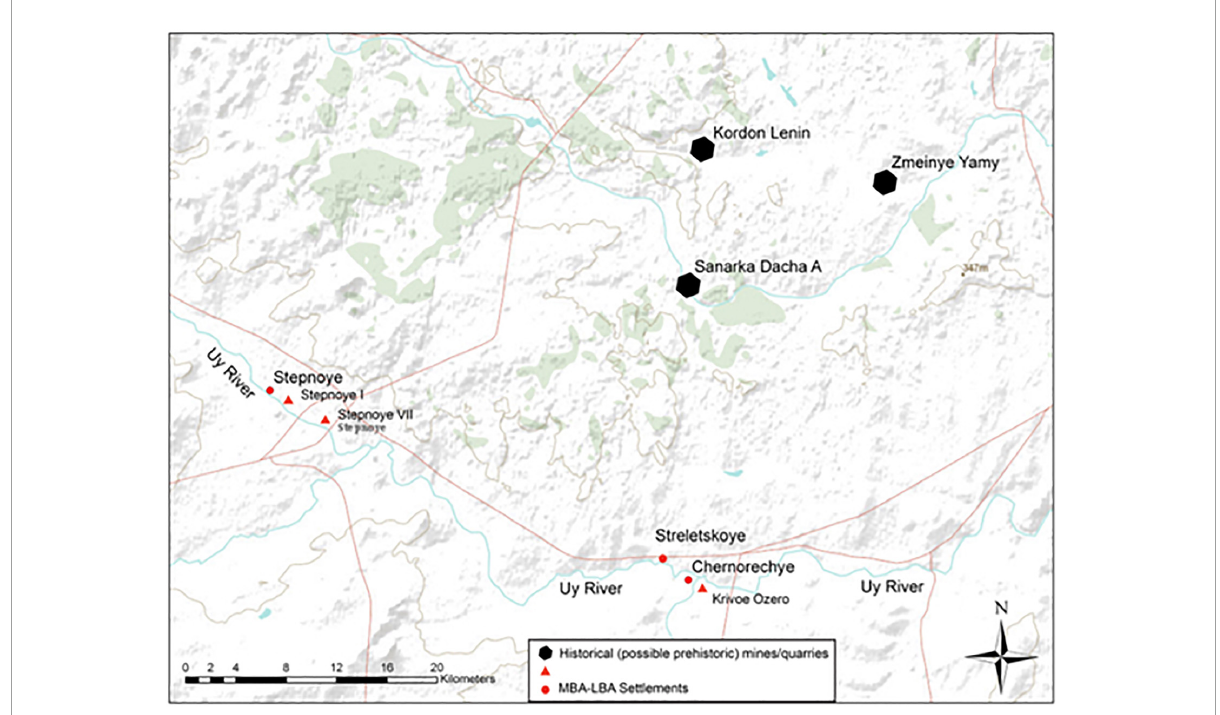
FIGURE2 Map of Uy River valley showing key Bronze Age sites [modified from Doonan et al.